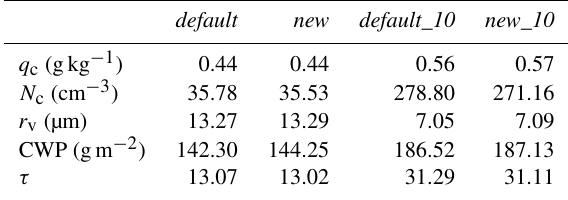
Table 2. Summary of the case mean values of the key quantities in all the simulations of the cumulus case, containing cloud water mixing ratio ( q c ), cloud droplet number concentration ( N c ), cloud droplet volume mean radius ( r v ), cloud water path (CWP), and cloud optical depth ( τ ). The experiments are detailed in Table